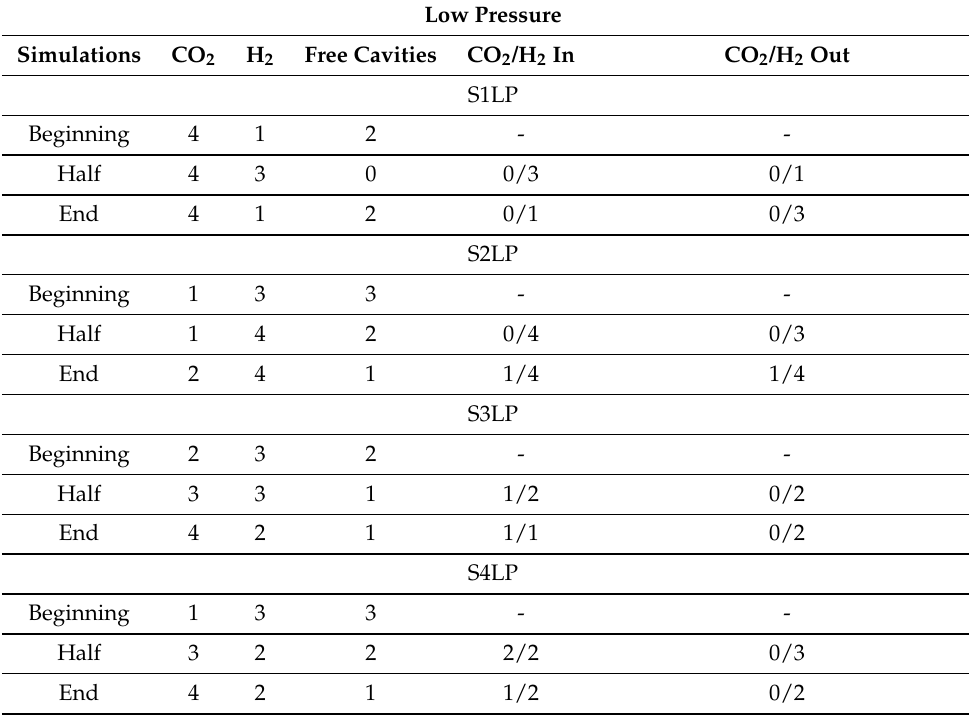
Table 2. Simulations for the LP runs (300 K and 0.005